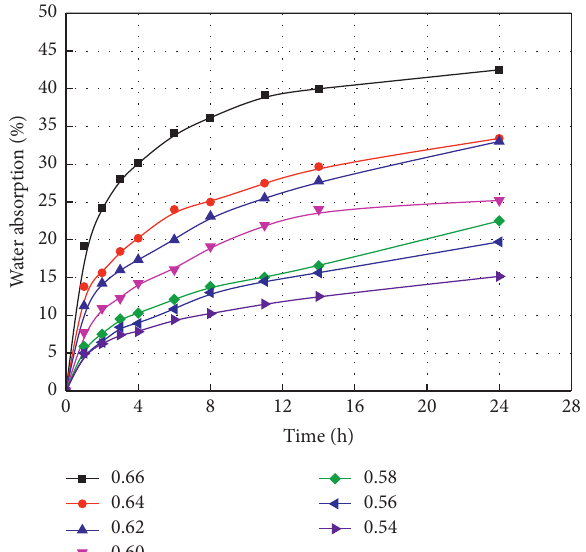
Figure 16: Water absorption of foamed concrete under different water-cement ratios.